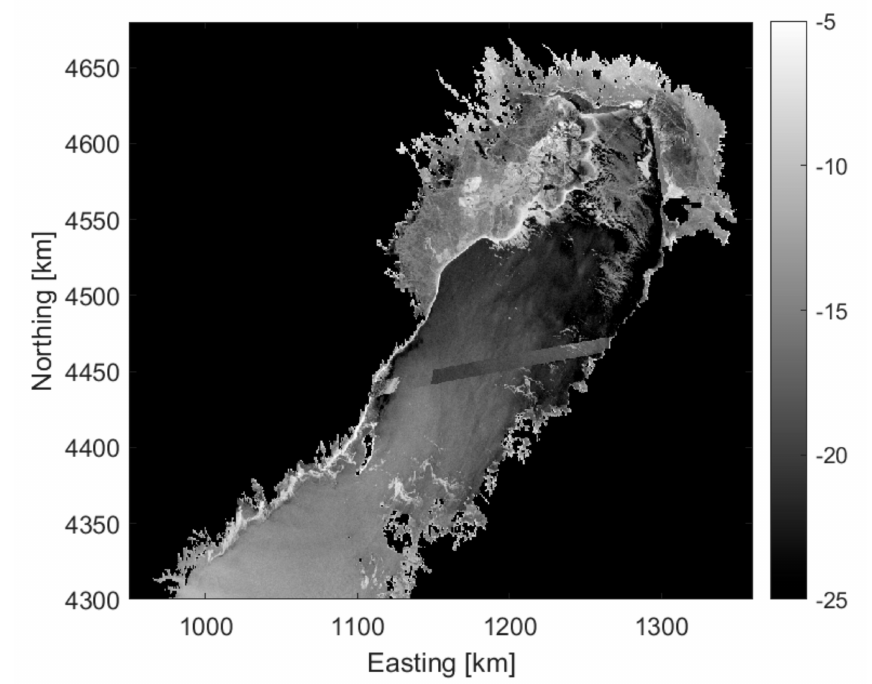
Figure 2. Daily SAR HH-polarization mosaic on 5 March 2020 when the Baltic Sea ice had the largest extent during the ice season 2019–2020. Only the Bay of Bothnia is shown as there was very little sea ice elsewhere. Grey scale shows SAR backscattering coe ffi cient in